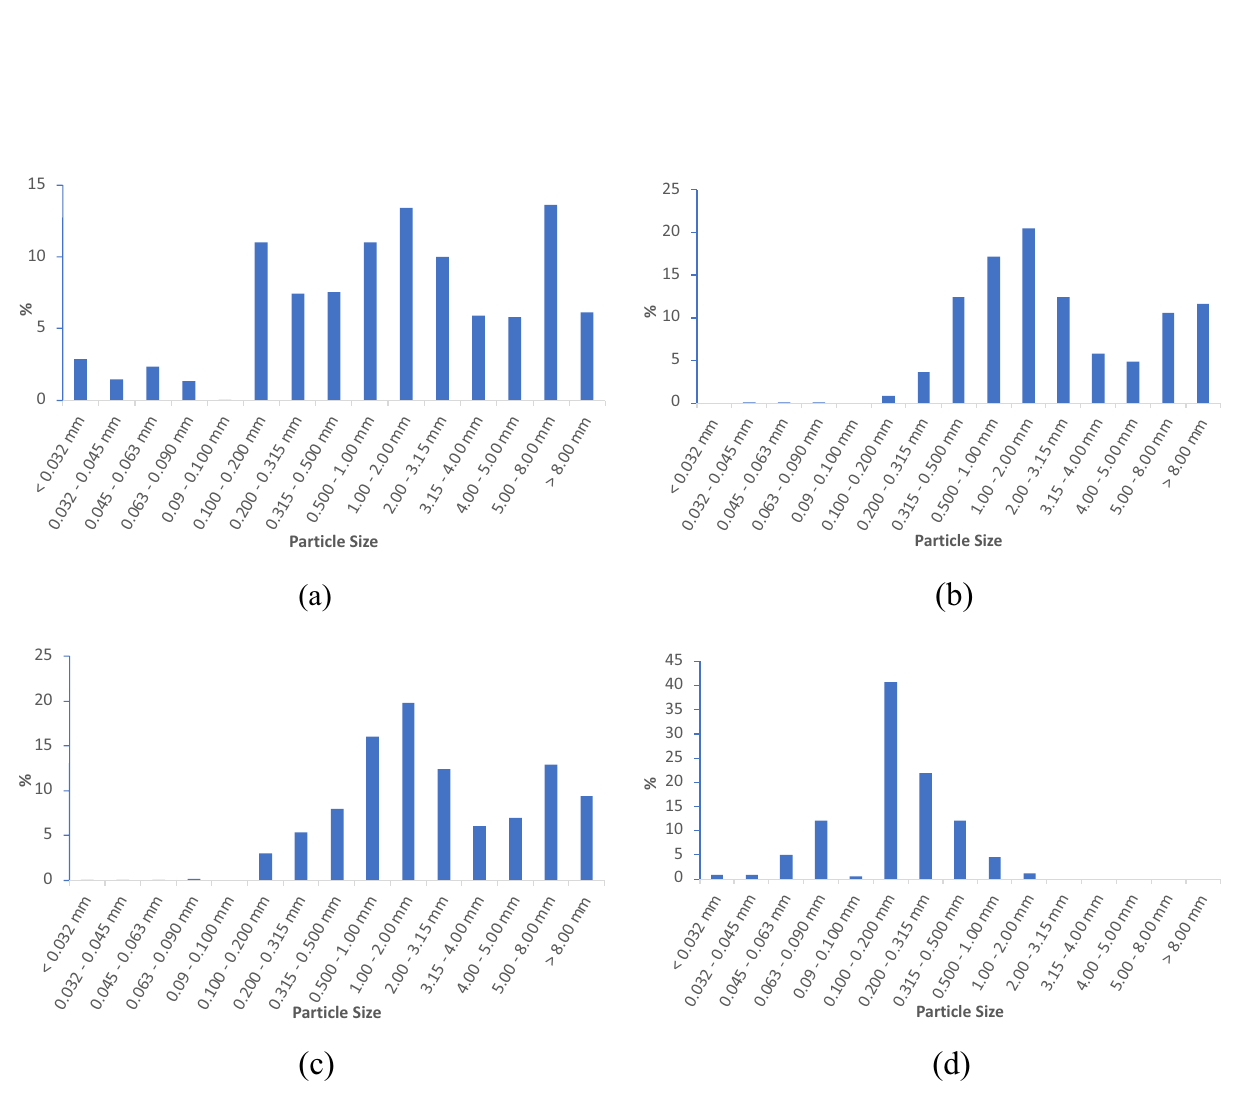
Figure 2. Particle size distributions for the four types of iron ores used in this study ( a ) IO-1, ( b ) IO-2, ( c ) IO-3, ( d )